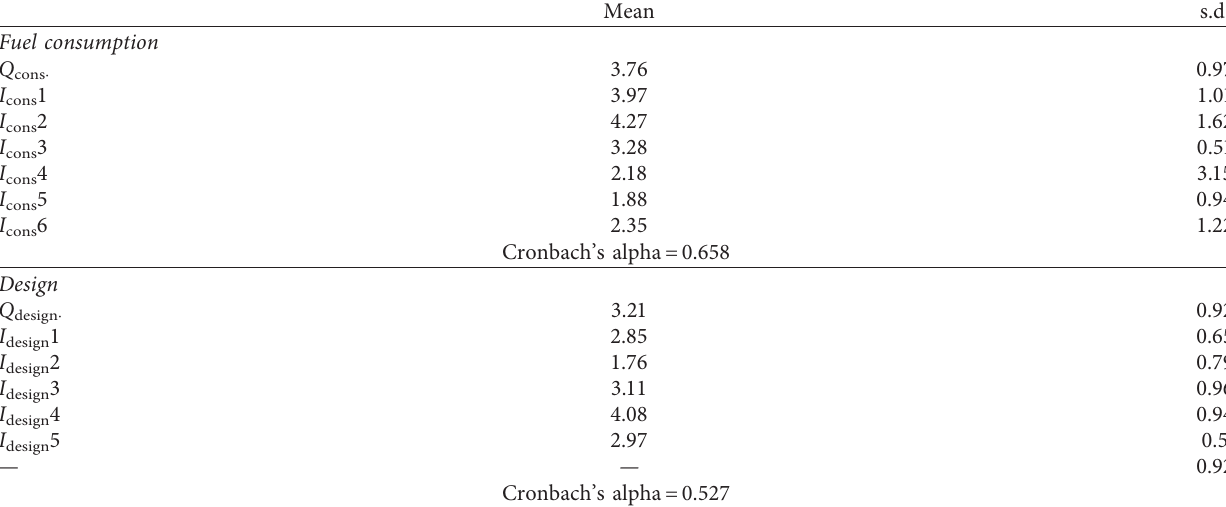
Table 5: Summary of the mean values and the standard deviations of the collected preferences and Cronbach’s alpha